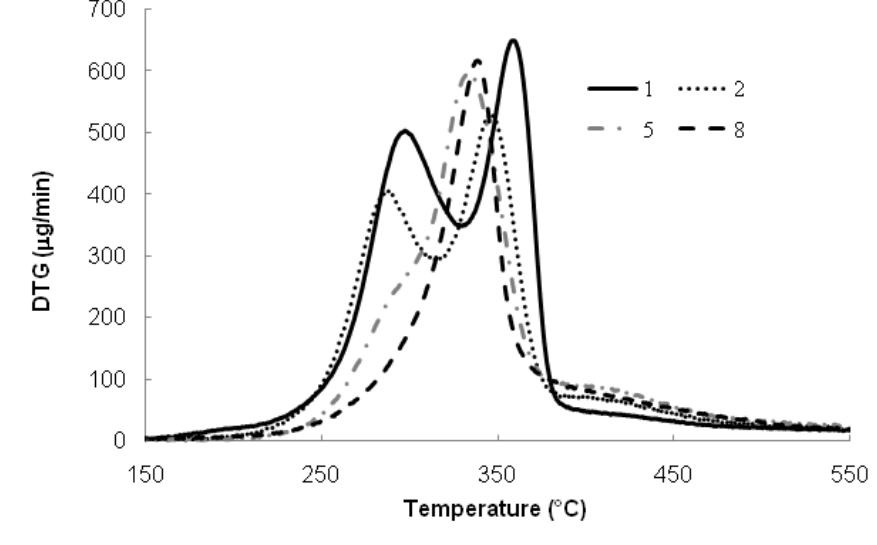
Figure 2. DTG analysis for untreated OPMF (1) and SHS-treated OPMF; at 190 °C (2), 210 °C (5) and 230 °C (8), for 1 h of